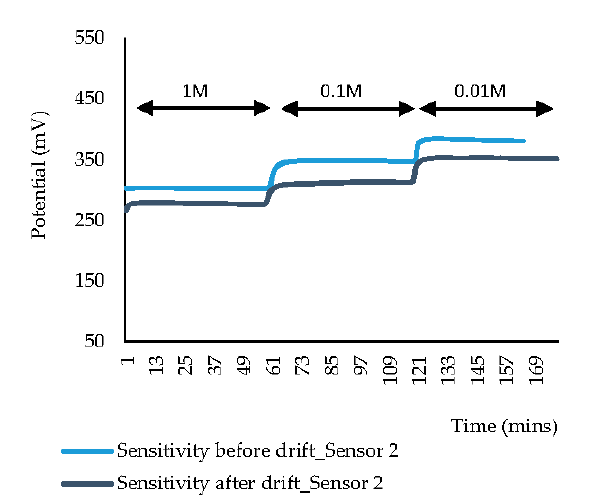
Figure 1. Sensitivity and repeatability tests of Sensor 2.